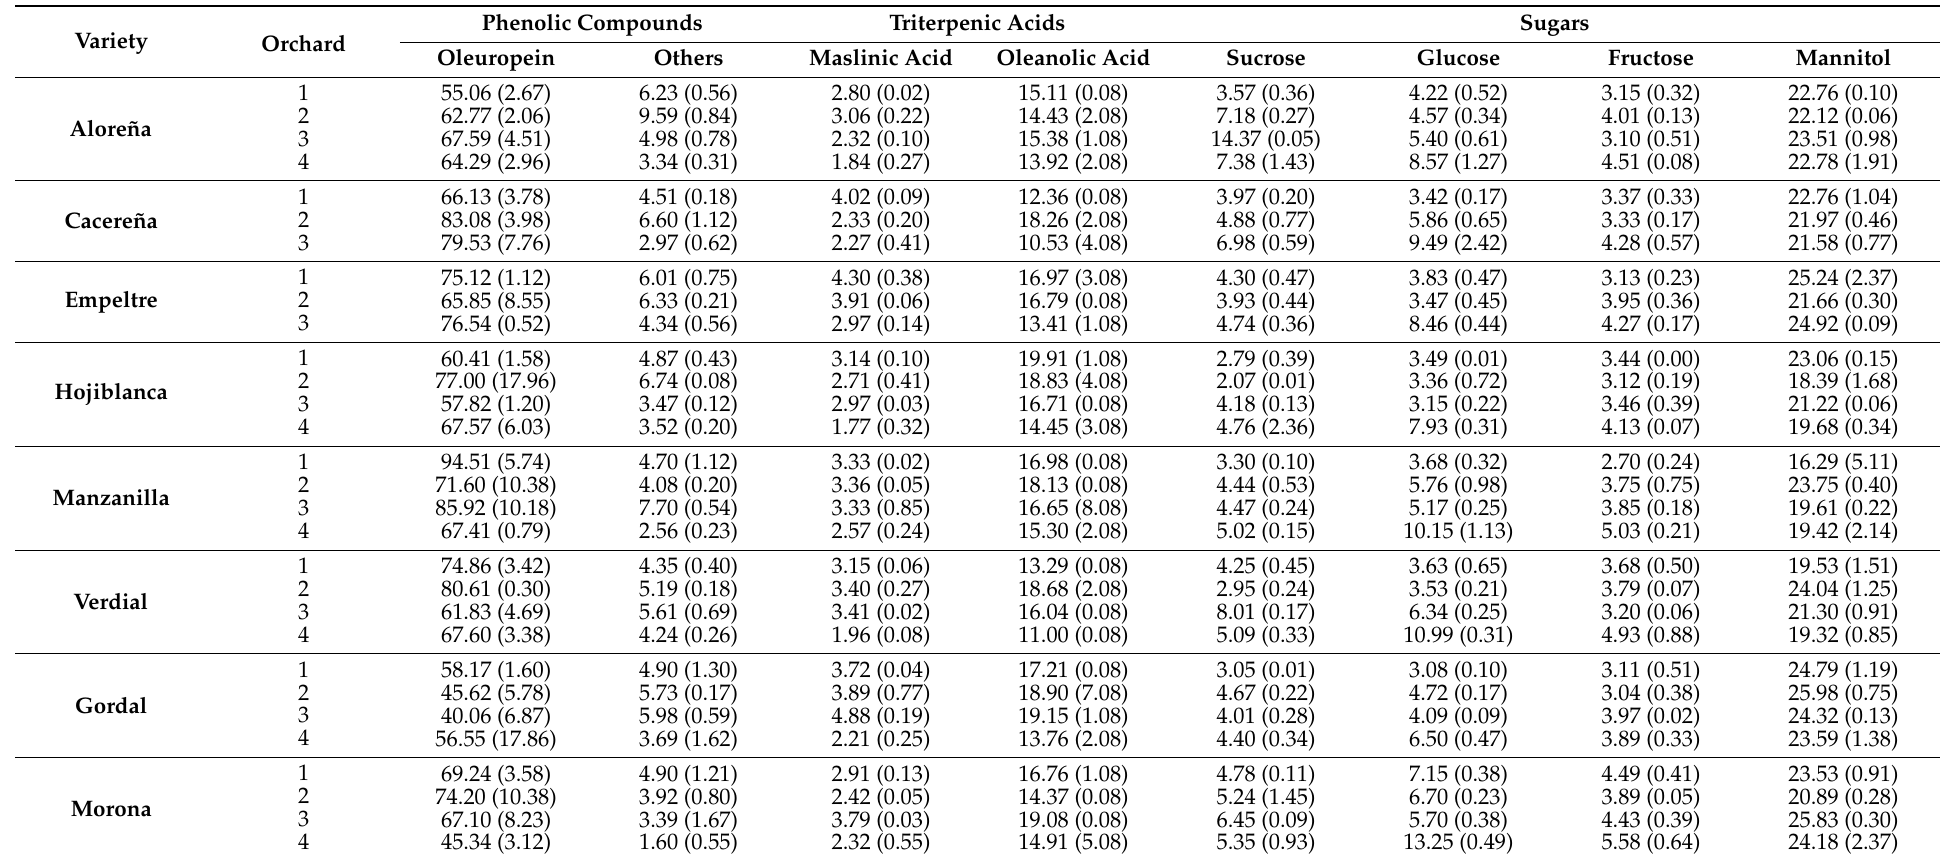
Table 1. Concentration of phenolic compounds, triterpenic acids and sugars (g/kg) in the olive leaf samples from 4 different orchards. Data are expressed as the mean values of duplicates. Standard deviation is in parenthesis. “Others” is the sum of hydroxytyrosol 4-glucoside, hydroxytyrosol 1-glucoside, tyrosol, caffeic acid, verbascoside, ligustroside and luteolin